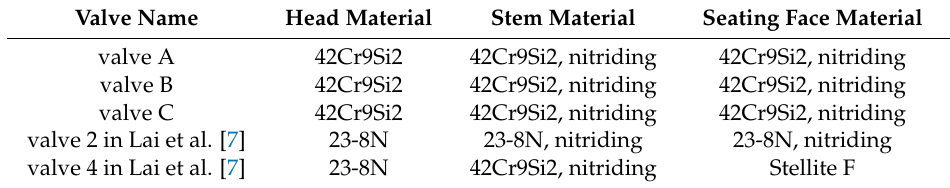
Figure 13. ( a ) Three-dimensional CAD (Computer Aided Design) model of the self-designed bench-top apparatus; ( b ) the manufactured apparatus; ( c ) the schematic diagram of the apparatus. Table 6. Properties and configurations of HHSV specimens.